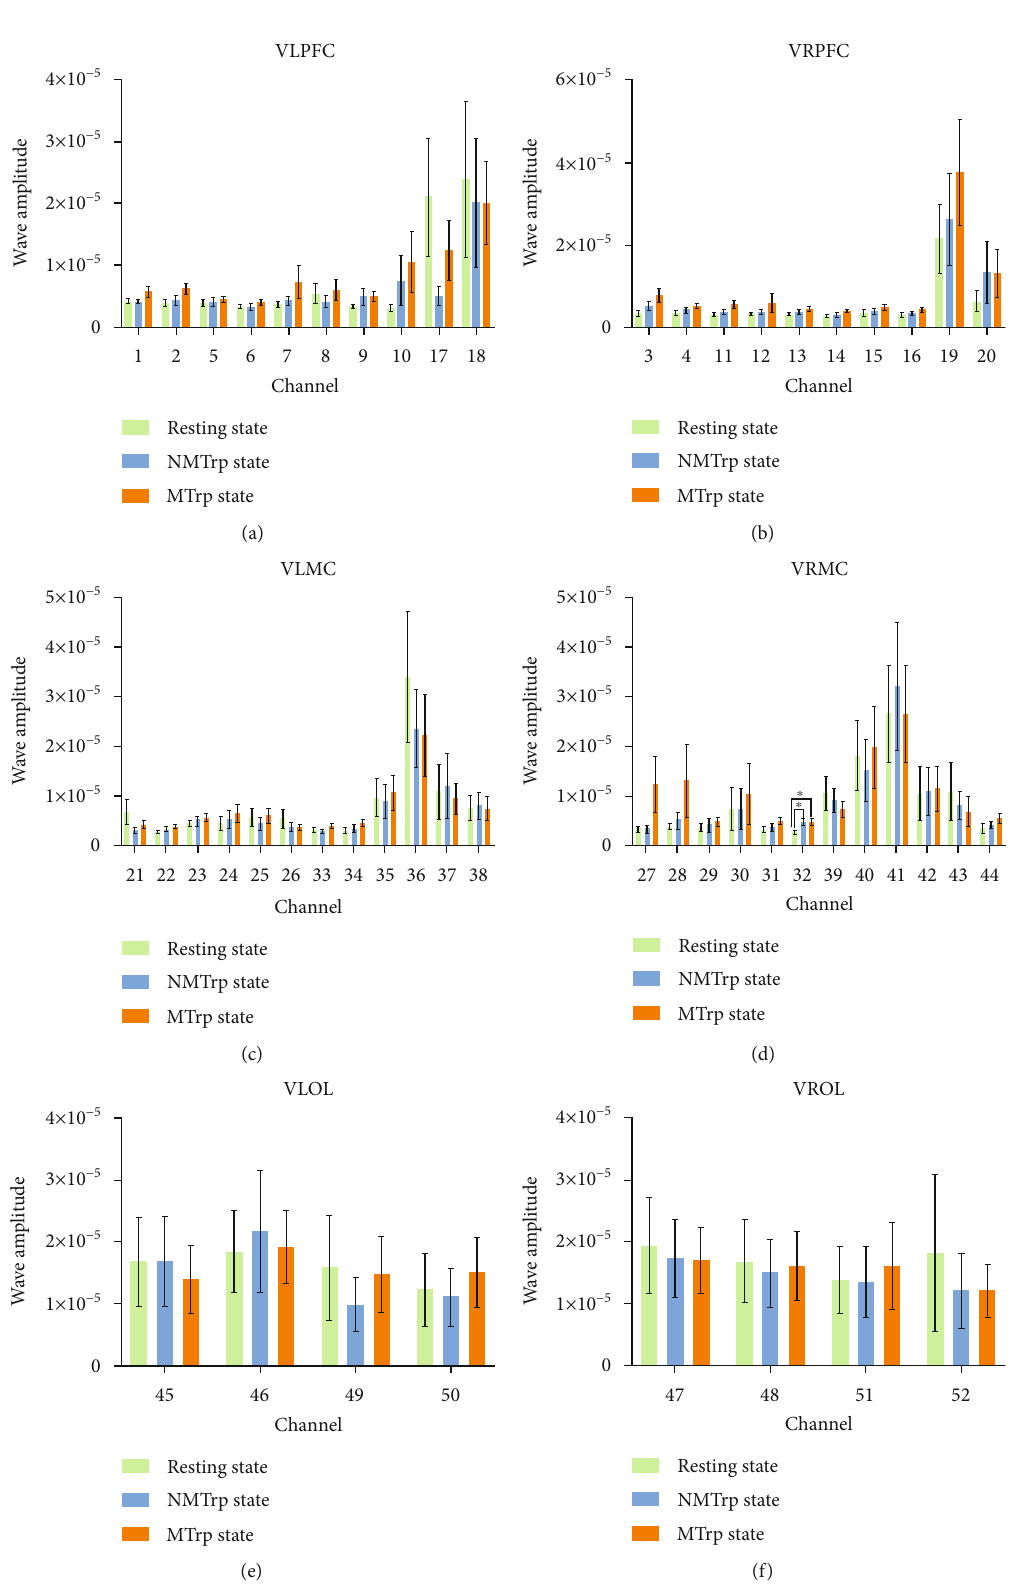
Figure 5: Comparison of wavelet amplitude (WA) changes among three stages in frequency interval V: PFC (a and b), MC (c and d), and OL (e and f). Error bars are mean ± s : e : m : ∗ : p < 0 : 05 ; ∗∗ : p < 0 : 01 ; ∗∗∗ : p < 0 : 001 . MTrP: myofascial trigger point; NMTrP: nonmyofascial trigger point; L: left; R: right; PFC: prefrontal cortex; MC: motor cortex; OL: occipital